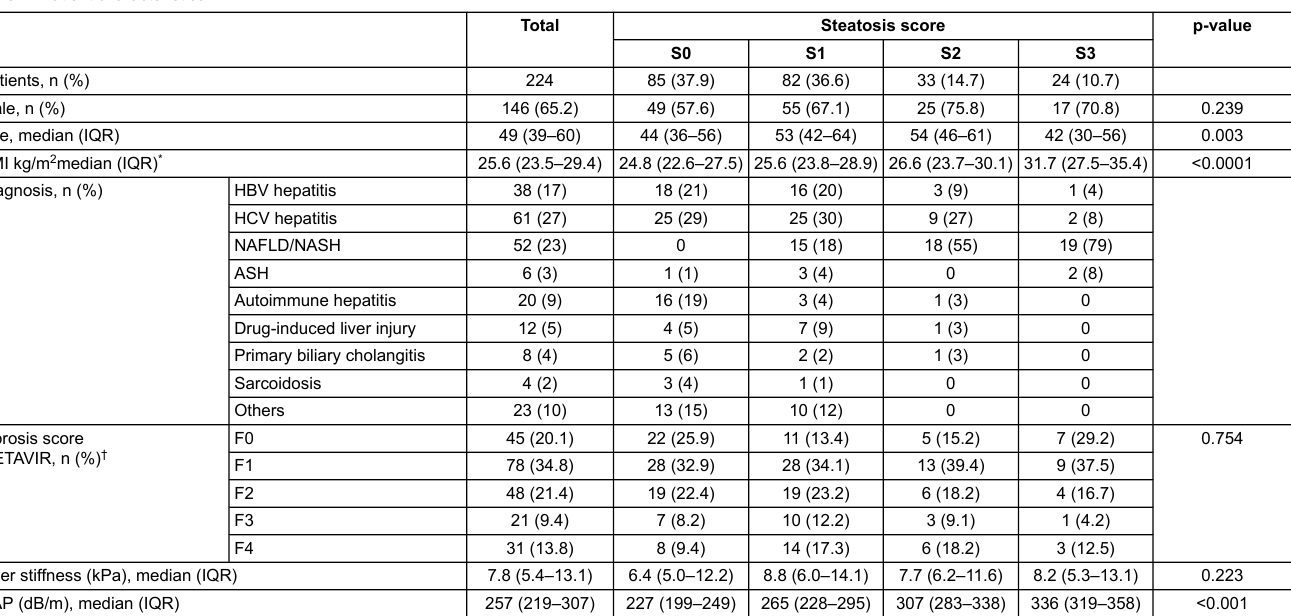
Table 1: Patient characteristics.